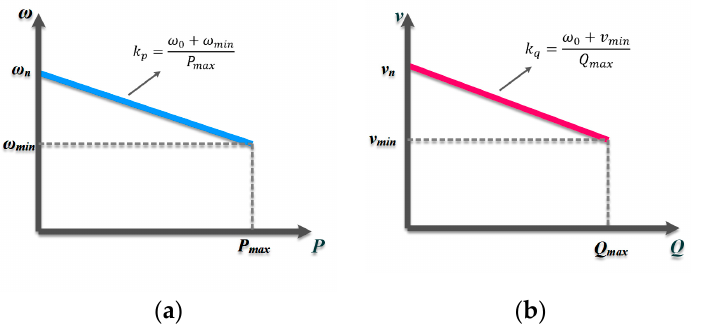
Figure 9. Conventional droop curves: ( a ) active power vs. frequency curve; ( b ) reactive power vs. voltage curve.